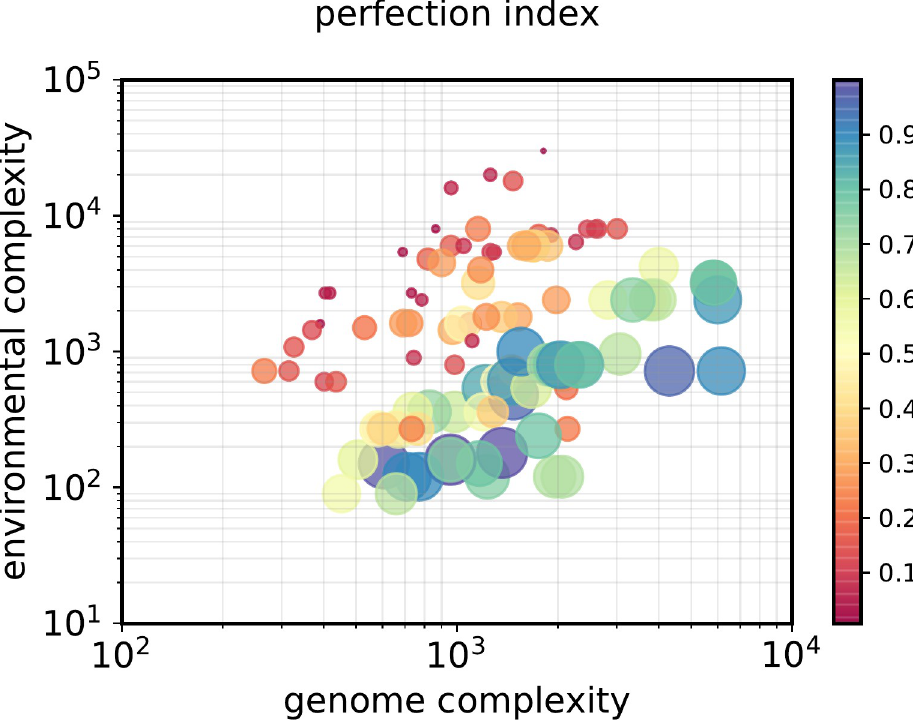
Fig 4. Selection is inefficient for runs with a combination of high environmental complexity and low genome complexity. X axis: Genome complexity (number of genes in each organism time the number of types of bases of which those genes are made up, times the average length of the genes at the end of the selection process. Y axis: Environmental complexity; number of environmental factors that must match the genotype, multiplied by the number of different environments to be fitted, the number of base types in each sequence, and the length of the environmental strings to be matched. The ‘perfection index’–fitness at selection plateau divided by maximum possible fitness–is both proportional to the circle areas and, for enhanced readability, to the colour scale (vertical